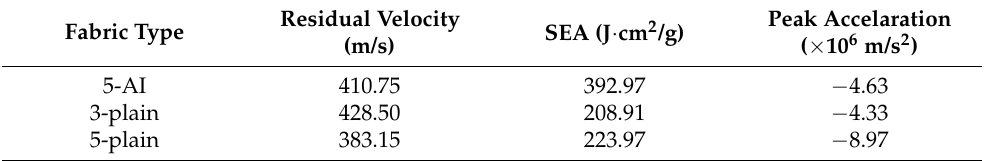
Table 3. The ballistic performance of fabric